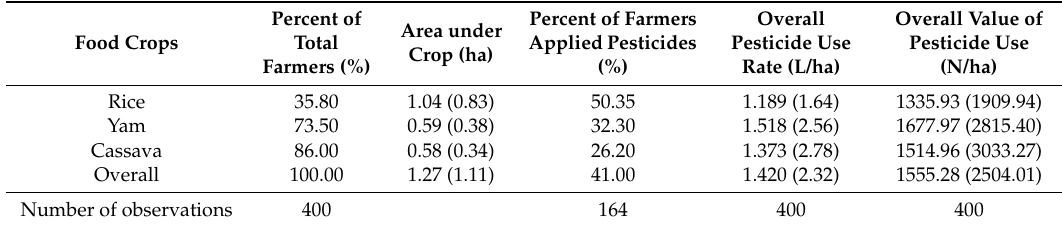
Table 2. Extent of pesticide use by major food